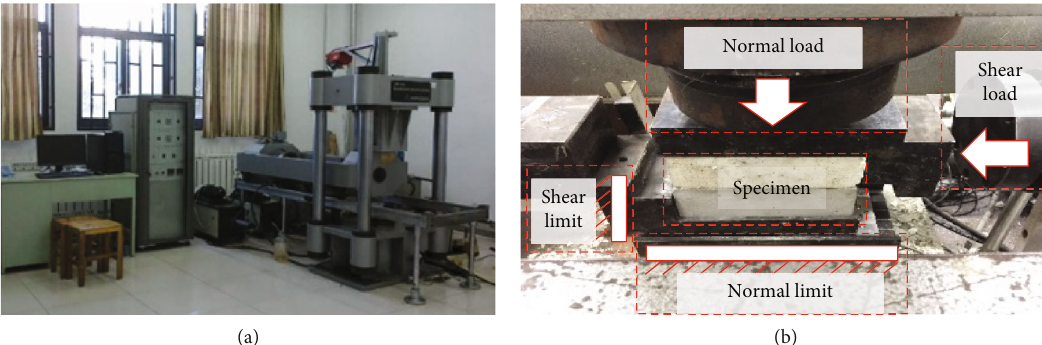
Figure 1: Arrangement of the shear test [41]: (a) shear test system; (b) loading unit.